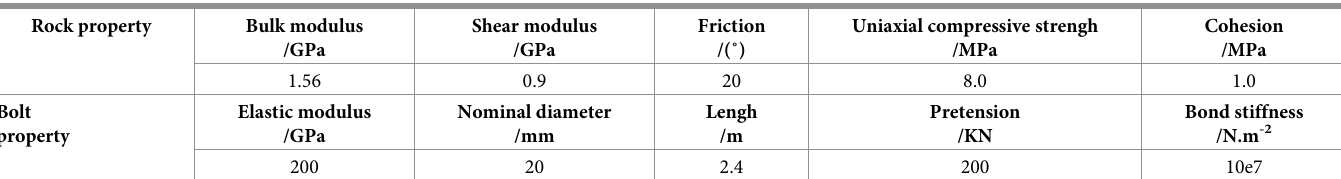
Table 1. Mechanical parameters of rock